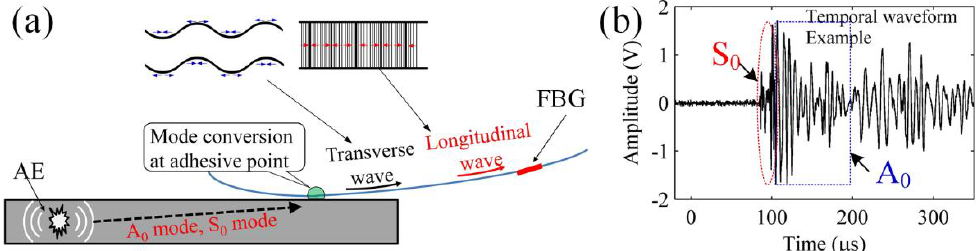
Figure 9. The ultrasonic wave propagation along an optical fiber. ( a ) The principle of remote sensing; ( b ) a typical waveform detected by remote